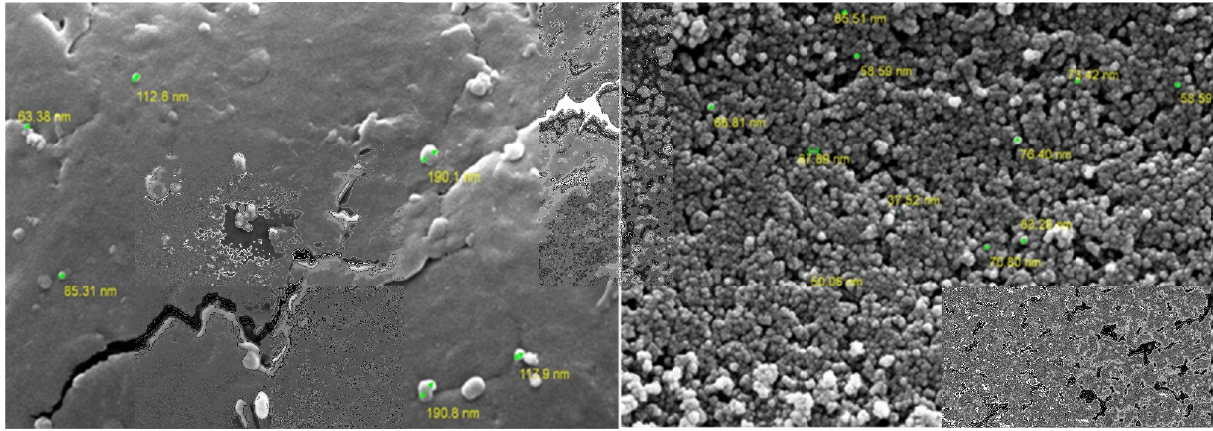
Images of SiO NPs (right) and chitosan NPs (left) by Field 2